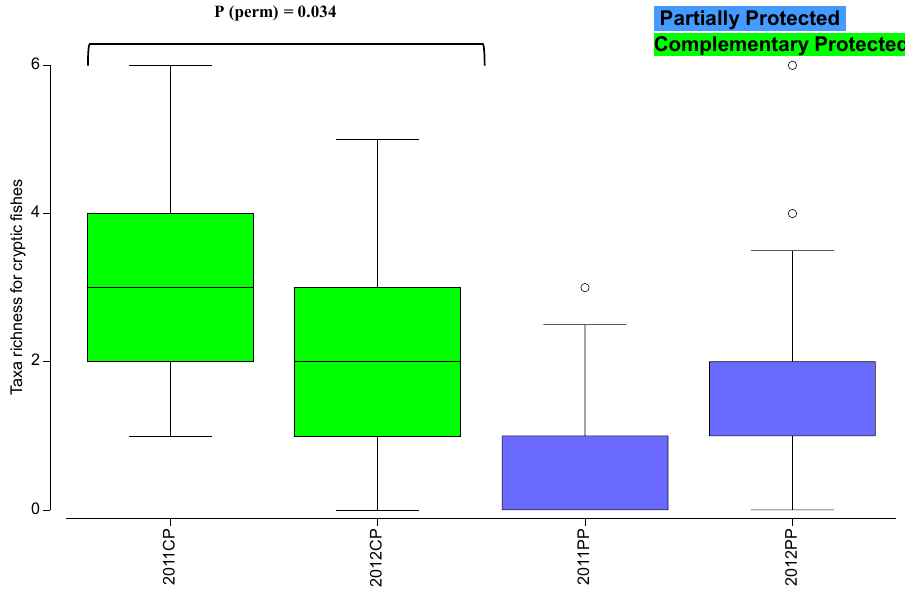
Figure 4. Cryptic fishes’ spatial-temporal variation of taxa richness (boxplot) in 2011 and 2012 in partially protected areas (PP) and adjacent control areas (complementary protection areas; CP) of the northern marine PNSACV. Pairwise tests showed significant differences between years in CP areas, as indicated.